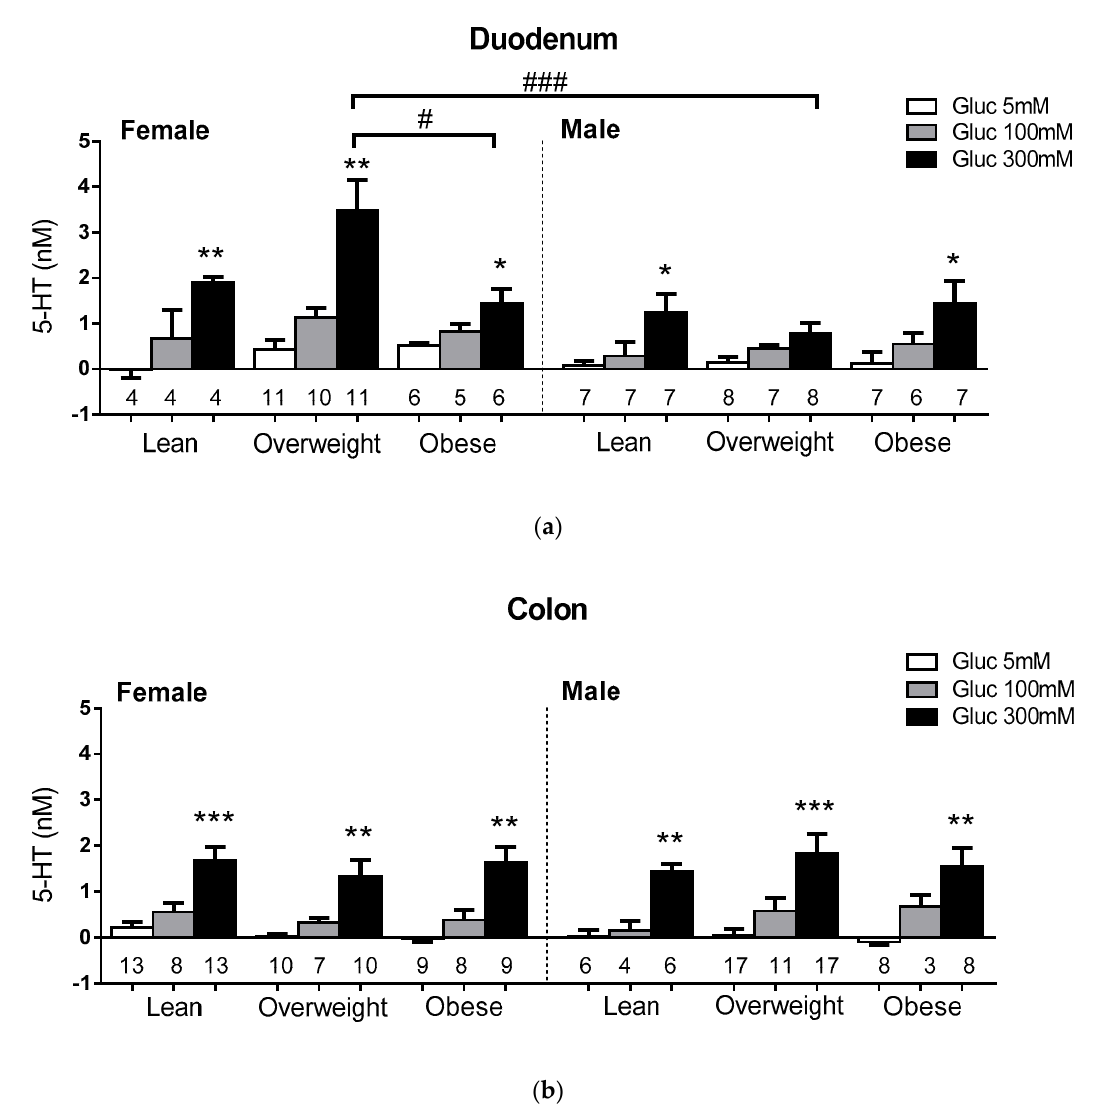
Figure 3. Glucose-evoked 5-HT secretion from human EC cells. Glucose-evoked responses of EC cells from ( a ) duodenum and ( b ) colon. The number of patients in each group ( n ) is shown under each bar. * represents significant differences compared to 5mM glucose, and # represents significant differences between BMI groups and between sexes. p < 0.05 (*, #), p < 0.01 (**), p < 0.001 (***, ###).